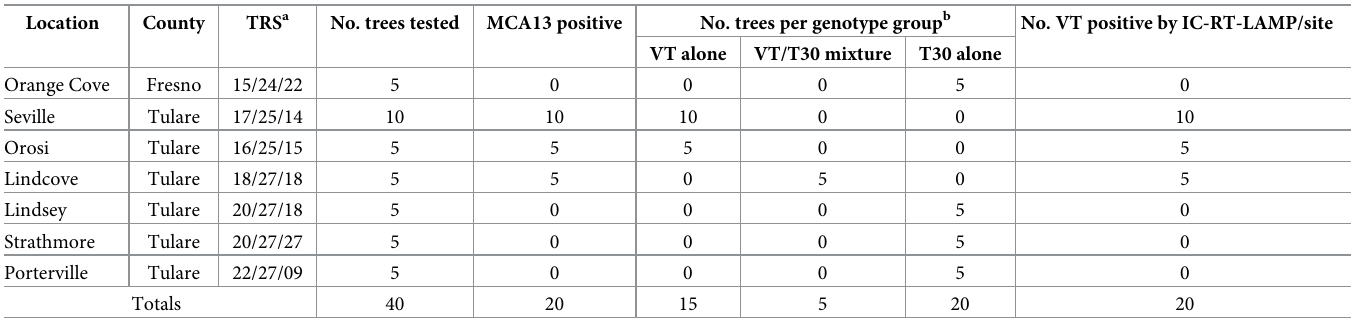
Table 4. Comparison of genotyping of Citrus tristeza virus -positive field trees tested in central California by TaqMan hydrolysis probe versus IC-RT-LAMP.